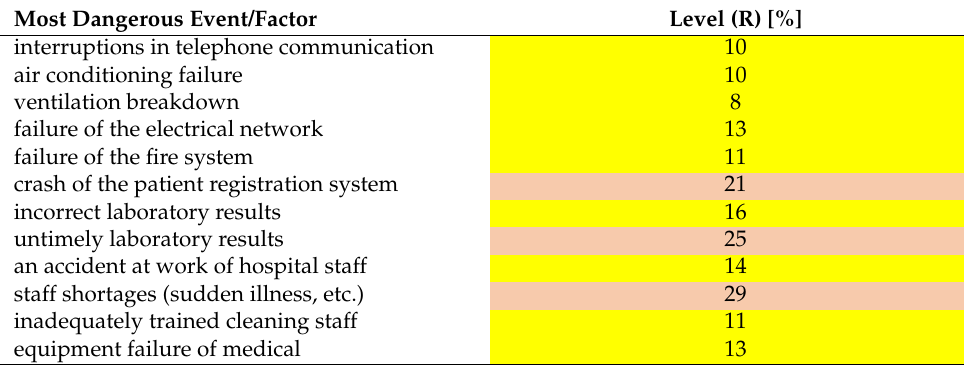
Table 9. Relative risk (R) for the gravest events/factors in the category of technical facilities (hospital’s failure rates).